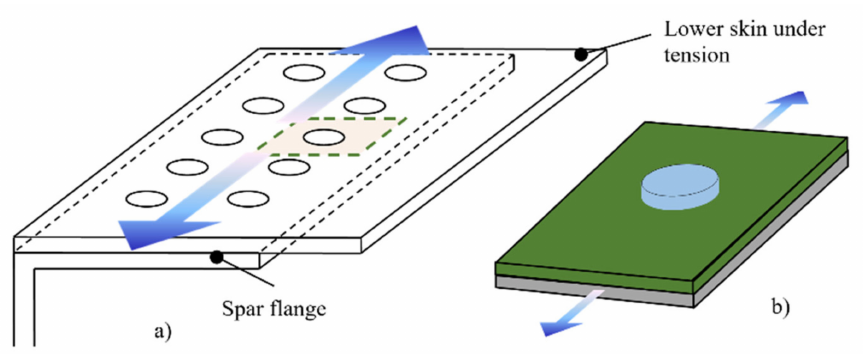
Figure 2. Conceptual model of the bolted joint. ( a ) Typical bolted joint between two consecutive ribs and ( b ) simulating a single lap joint that receives half the load in the longitudinal